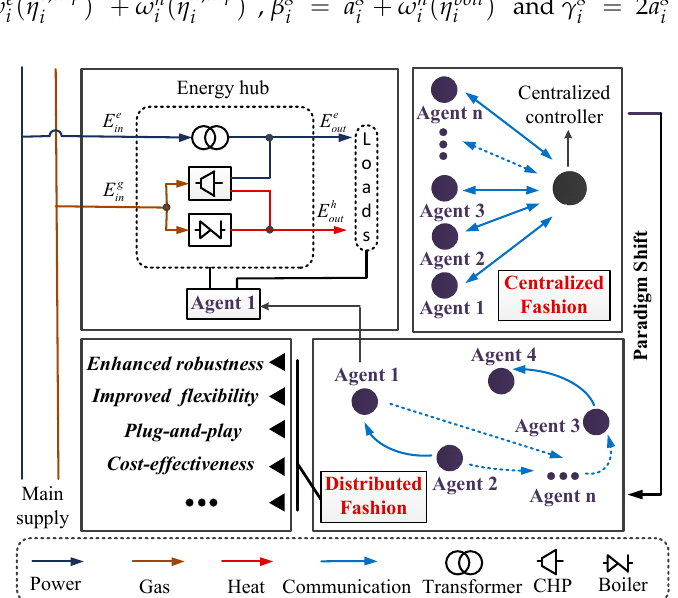
Figure 1. Structure of a multiple energy hubs system.